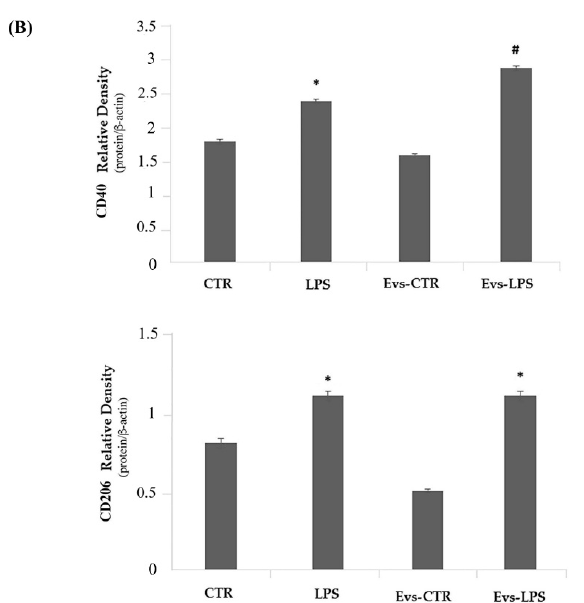
Figure 7. Panel ( A ) Western blotting detection of pro-inflammatory CD40 and anti-inflammatory CD206 in untreated cells (CTR), cells stimulated with LPS, EVs-CTR, and EVs-LPS. Densitomentric analysis of expression levels of the pro-inflammatory CD40 (Panel B , upper) and anti-inflammatory CD206 (Panel B , lower) * p -value < 0.05 compared to the control; # p -value < 0.05 in comparison to LPS-treatment. Protein expression levels were normalized to β -actin and results of densitometric analysis are expressed as the mean ± SD of five independent experiments.